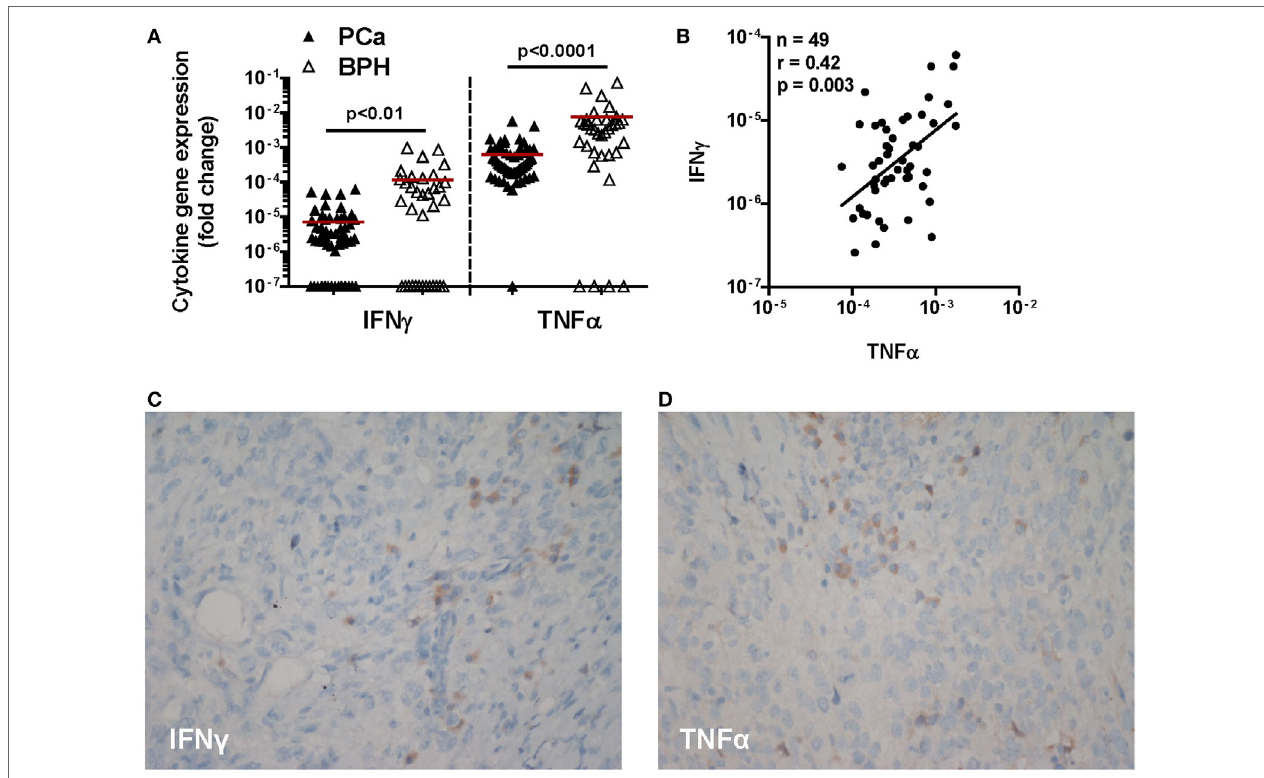
FigUre 1 | Expression of IFN- γ and TNF- α genes and immunohistochemical cytokine detection in prostate cancer (PCa) tissues. (a) Expression of IFN- γ and TNF- α genes in PCa (black triangles) and benign prostatic hyperplasia (BPH) (open triangles). A higher expression of both cytokine genes in BPH than in PCa tissue specimens was observed (Mann–Whitney U test, IFN- γ p < 0.01 and TNF- α p < 0.0001). The 2 −ΔΔ Ct method was used to compute fold changes in gene expression for both cytokines, setting GAPDH gene expression equal to 1. Values ≤ 10 7 were considered undetectable. (B) Fold changes in IFN- γ gene expression in either BPH or PCa tissue specimens were plotted against fold changes in TNF- α gene expression in same specimens. A significant correlation was only observed in PCa (Spearman rank correlation coefficient, r = 0.42; p < 0.01). (c,D) A representative image by immunohistochemistry (original magnification 200 × ; slight hematoxylin conterstaining) of a poorly differentiated prostatic adenocarcinoma (Gleason score 9) tissue specimen stained with (c) IFN- γ or (D) TNF- α